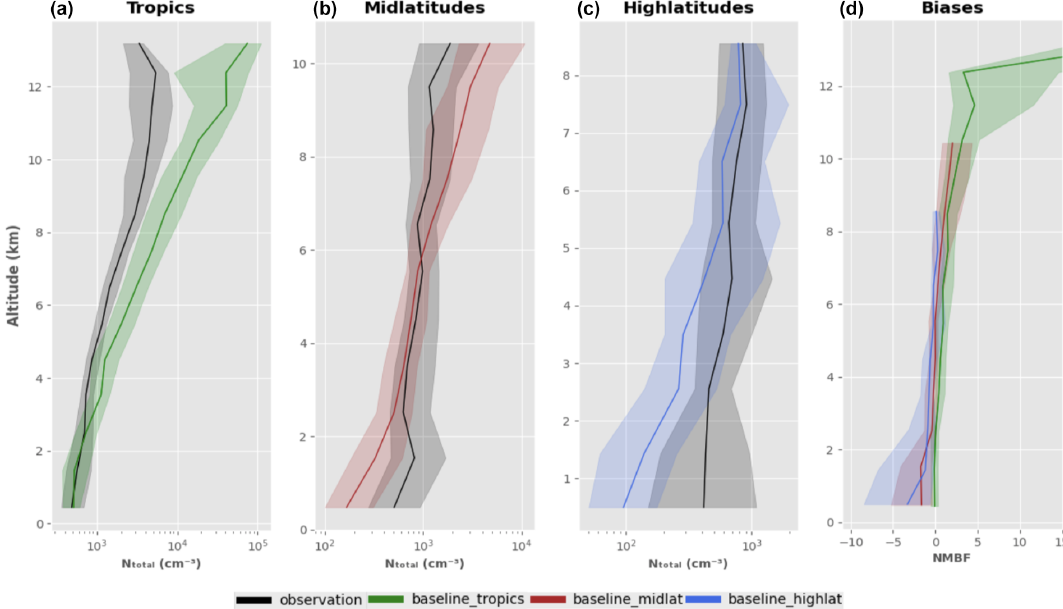
Figure 3. The first three columns show the vertical profile of the total particle number concentration (at standard temperature and pressure – STP) as observed (ATom1–4) and in the simulated data from the baseline (bug-fixed) configuration of UKESM in the tropics (25 ◦ N– 25 ◦ S), mid latitudes (25–60 ◦ N and 25–60 ◦ S) and high latitudes (60–90 ◦ N and 60–90 ◦ S). The fourth column shows the NMBF of the baseline simulation in the tropics, mid latitudes and high latitudes. The bold line represents the median and the shaded region represents the corresponding interquartile range (25th and 75th percentiles) in a 1km altitude bin.